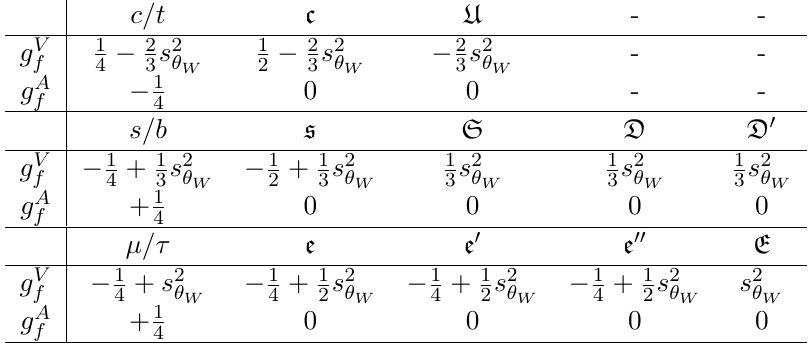
Table 12 . The couplings of the flavor-conserving neutral currents mediated by Z µ in the V − A basis, with θ being the Weinberg W